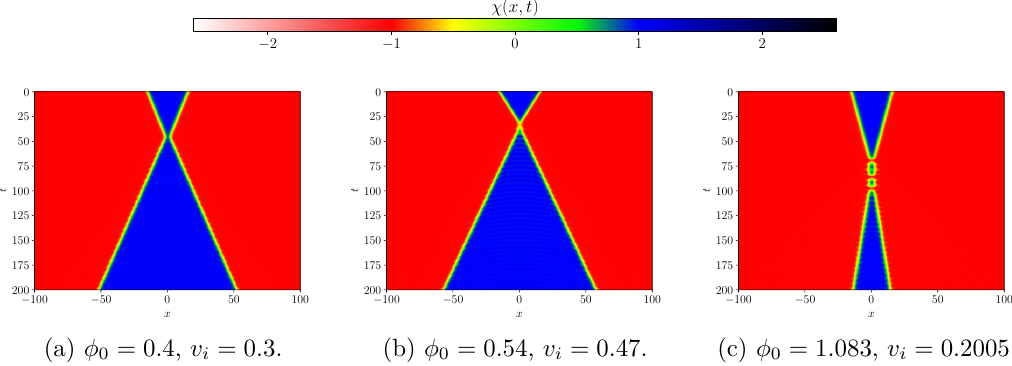
Figure 5 . Scalar field evolution in spacetime. We consider the repulsive case where the fermions start at the zero